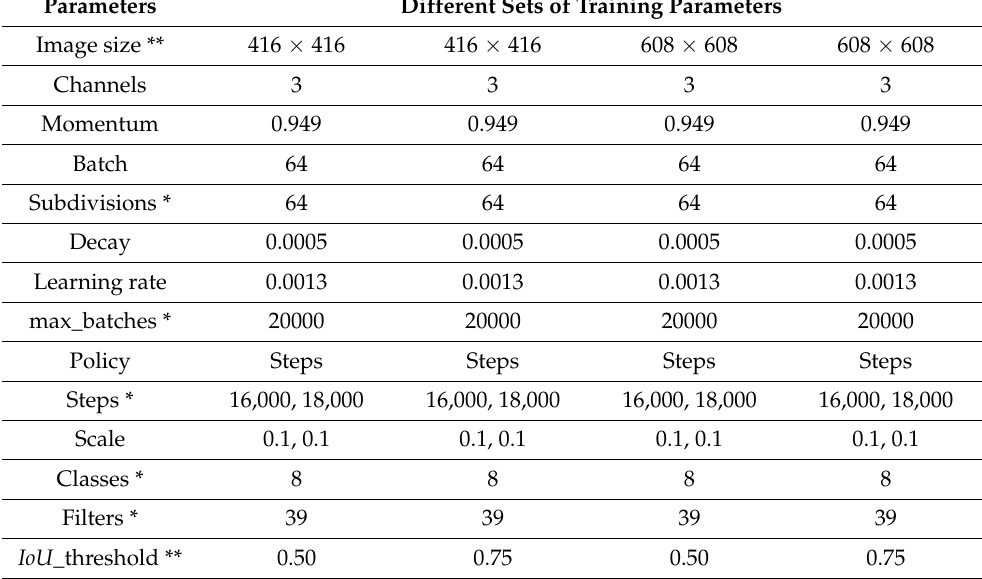
Table 3. YOLOv4 configuration parameters.